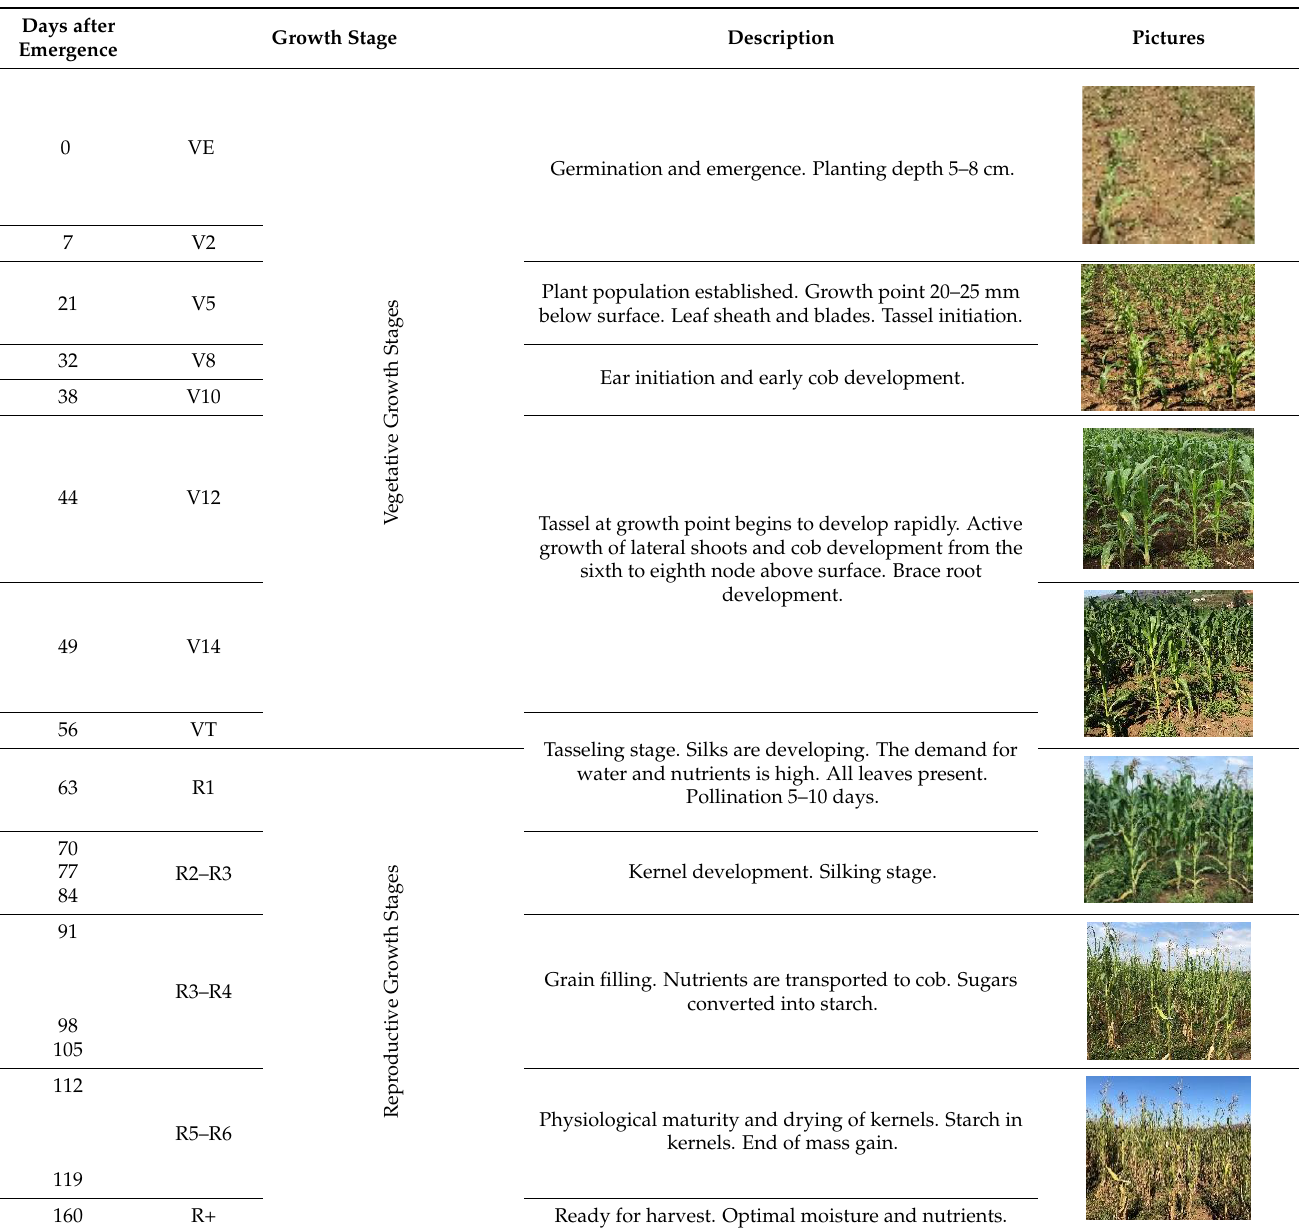
Table 1. Maize growth stages.